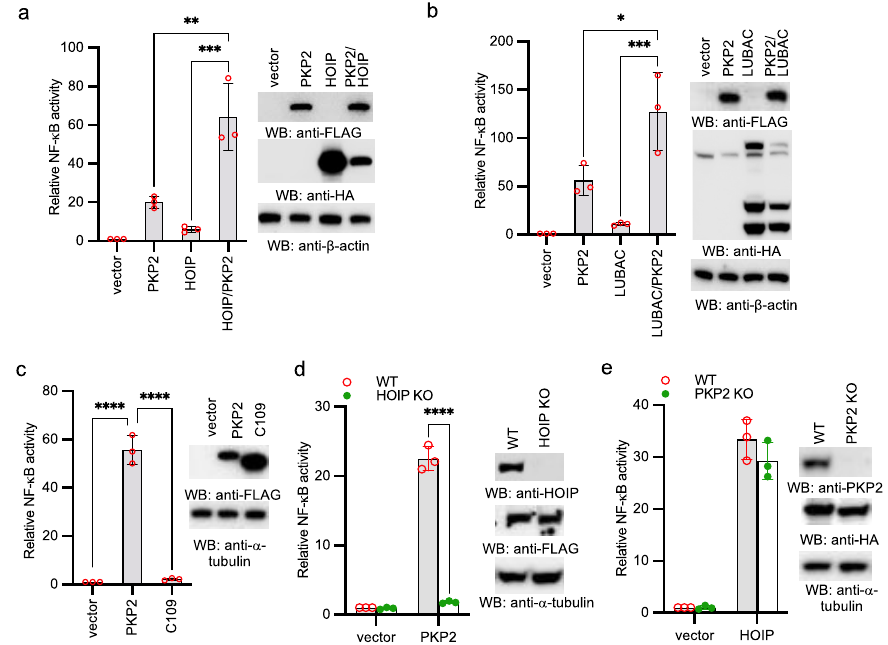
Figure 3. PKP2 activates NF- κ B via HOIP. ( a ) PKP2 was co-transfected with vector or HOIP, together with pRL-SV40 and NF- κ B-Luc, into HEK293 cells. After 48 h, cells were collected, and the ratio of firefly luciferase to Renilla luciferase was calculated to determine the relative reporter activity. Right panel shows protein expression levels by Western blotting. ( b ) PKP2 was co-transfected with vector or LUBAC (HOIP, HOIL-1, and SHARPIN), together with pRL-SV40 and NF- κ B-Luc, into HEK293 cells. After 48 h, cells were collected, and the ratio of firefly luciferase to Renilla luciferase was calculated to determine the relative reporter activity. Right panel shows protein expression levels by Western blotting. ( c ) PKP2 or the C109 (aa 109-837) was co-transfected with pRL-SV40 and NF- κ B-Luc into HEK293 cells. After 48 h, cells were collected, and the ratio of firefly luciferase to Renilla luciferase was calculated to determine the relative reporter activity. Right panel shows protein expression levels by Western blotting. ( d ) HOIP wild type (WT) and knockout (KO) HEK293 cells were transfected with vector or PKP2-FLAG, together with pRL-SV40 and NF- κ B-Luc. After 48 h, cells were collected, and the ratio of firefly luciferase to Renilla luciferase was calculated to determine the relative reporter activity. Right panel shows protein expression levels by Western blotting. ( e ) PKP2 WT and KO HEK293 cells were transfected with vector or HOIP-FLAG, together with pRL-SV40 and NF- κ B-Luc. After 48 h, cells were collected, and the ratio of firefly luciferase to Renilla luciferase was calculated to determine the relative reporter activity. Right panel shows protein expression levels by western blotting. ( a – e ) All experiments were biologically repeated three times. Data represent means ± s.d. of three independent experiments. The p -value was calculated by one-way ANOVA ( a – c ), or two-way ANOVA followed by Sidak ’ s multiple comparisons test ( d , e ) (* p < 0.05, ** p < 0.01, *** p < 0.001, **** p < 0.0001).